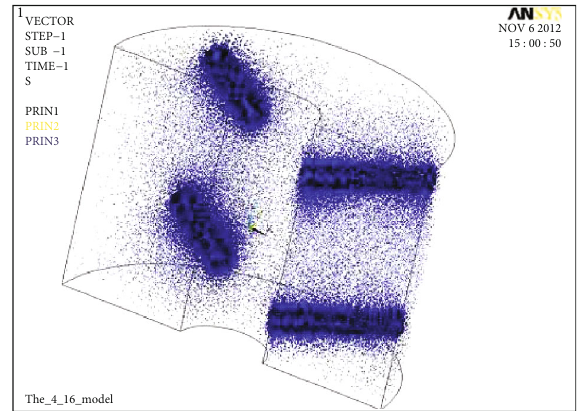
Figure 2: Stress distribution vector map of conventional spiral perforation.